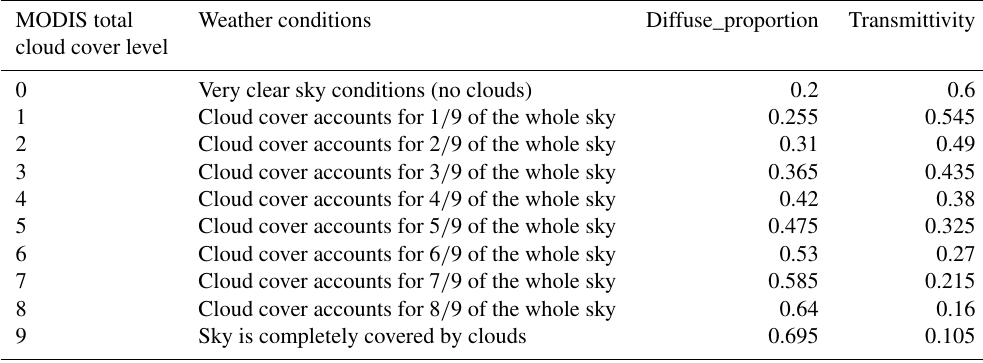
Table 2. Diffuse_proportion and transmittivity values under different total cloud cover levels. MODIS total Weather conditions Diffuse_proportion Transmittivity cloud cover level Cloud cover accounts for 1 / 9 of the whole sky Cloud cover accounts for 2 / 9 of the whole sky Cloud cover accounts for 3 / 9 of the whole